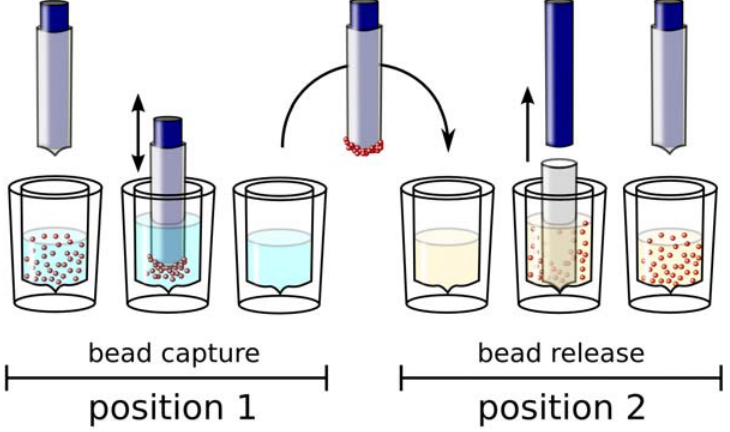
Figure 3. Principle of aspiration-free magnetic bead handling. Particles can be captured by a magnet covered by a plastic sheath and transferred to a new well by withdrawal of the attracting magnet from its cover (Figure taken from [55]; © 2009 BioTechniques. Used with